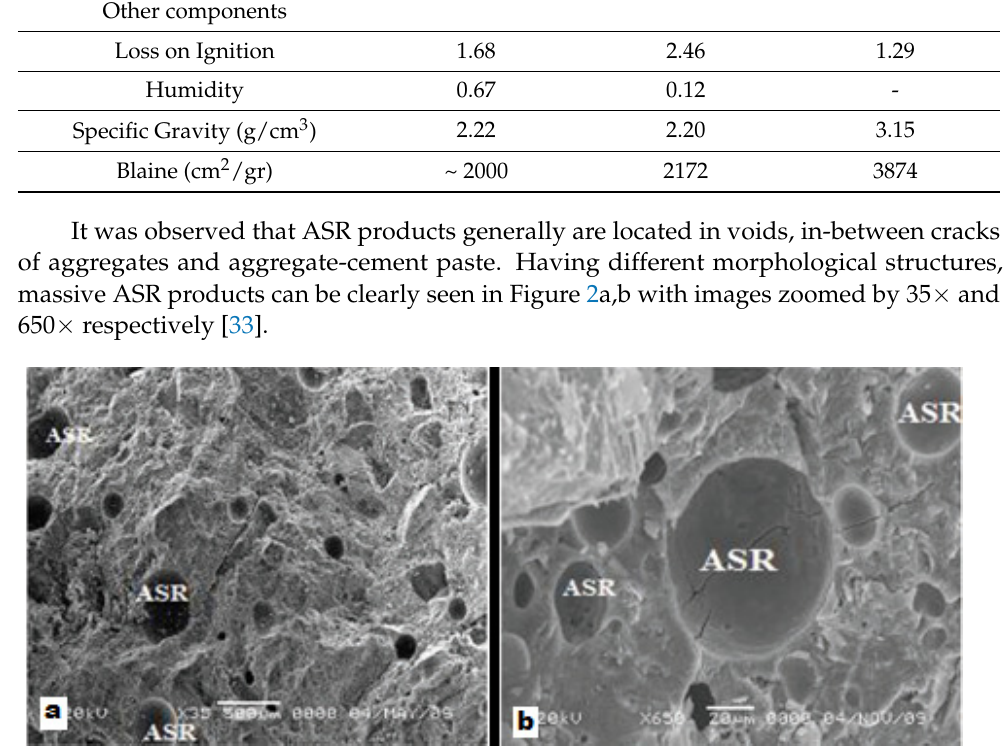
Figure 3. SEM images of mortar bar samples of granite: ( a,c ) typical expansion cracks produced in gel, ( b ) close view of same cracks [34]. The alkali silica reaction (ASR) effects on mortars containing various proportions of silica fume (SF) and fly ash (FA) as replacement of cement were investigated with respect to the ASTM C 1260-07 standards [35]. It is noted that the least strength loss in the mortars exposed to ASR occurred in those samples which had 20% SF substitution that provided 18% better flexural strength and compressive strength compared to the mortars with FA. 2. Materials and Methods In this paper, as admixture materials fly ash (FA) from the Kahramanmara ş Af ş in Elbistan Thermal Reactor (Af ş in, Turkey), was taken. Silica fume (SF) was from the İ stan- bul Aryum Company (Istanbul, Turkey) and cement from the Limak Ergani Cement Plant (Limak Holdings Inc., Ankara, Turkey) of Portland 42.5 cement category that is similar to ASTM C type have been utilized, as tabulated in Table 3. Analysis results of mineral admixtures were conducted at the Limak Ergani Cement Plant. Determinations of specific surface area of the materials were made via a Blaine test using Blaine test equipment in compliance with TS EN 196:6, ASTM C 204 standards, and an approximate value of the specific surface area of silica fume was obtained using the nitrogen adsorption method. Physical and chemical analysis results of the materials ap- plied during the test are shown comparatively in Table 3.